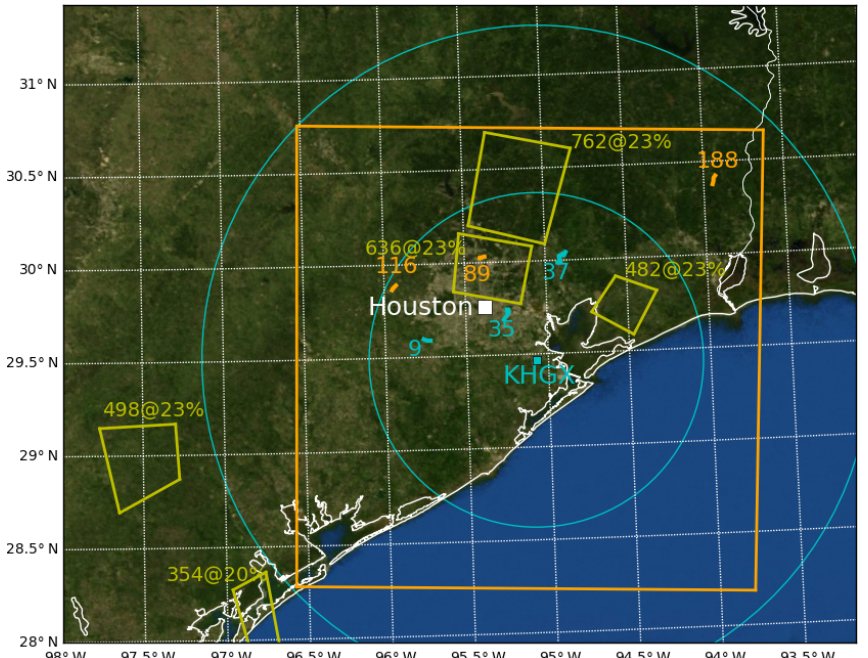
Figure 1. Map of Houston region (white symbol marks city center), NU-WRF inner domain boundaries (orange square), KHGX NEXRAD radar location (cyan symbol with 100 and 200km range rings), tracks of three example features from KHGX K DP observations (cyan tracks numbered 9, 35, and 37) and from NU-WRF q r output (orange tracks numbered 89, 116, and 188), and CCN number concentration and supersaturation retrieved from satellite data (within yellow boxes in number per cubic centimeter and as a percentage,